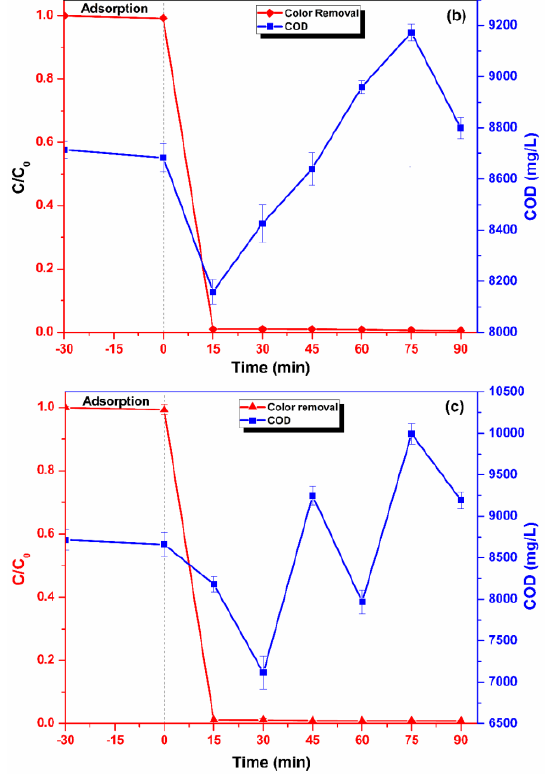
Figure 9. Treatment of real textile wastewater with: ( a ) 0.25 mM PMS and 100 mg/L catalyst dosage, ( b ) 2.5 mM PMS and 1000 mg/L catalyst dosage and ( c ) 1.25 mM PMS and 500 mg/L catalyst dosage.